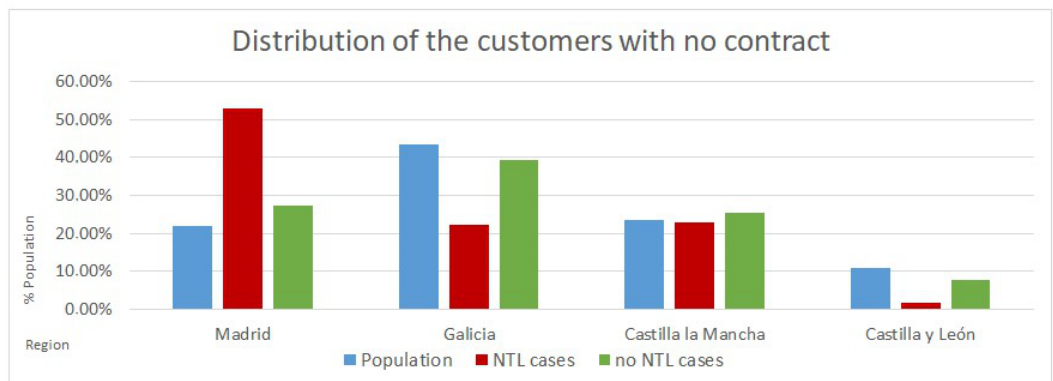
Figure 2. Real example of the dataset-shift problem between the proportions of the real domain. (customers from Spain with no contract in November 2018) and the labeled instances of the customers with no contract (feedback available from the same type of customer since October 2016); In the region of Madrid the company has more cases of NTL than in any other region, and this made that our system over-estimated the score assigned to the customers in that region. This was solved through a segmentation, generating two different campaigns (Madrid and the rest of